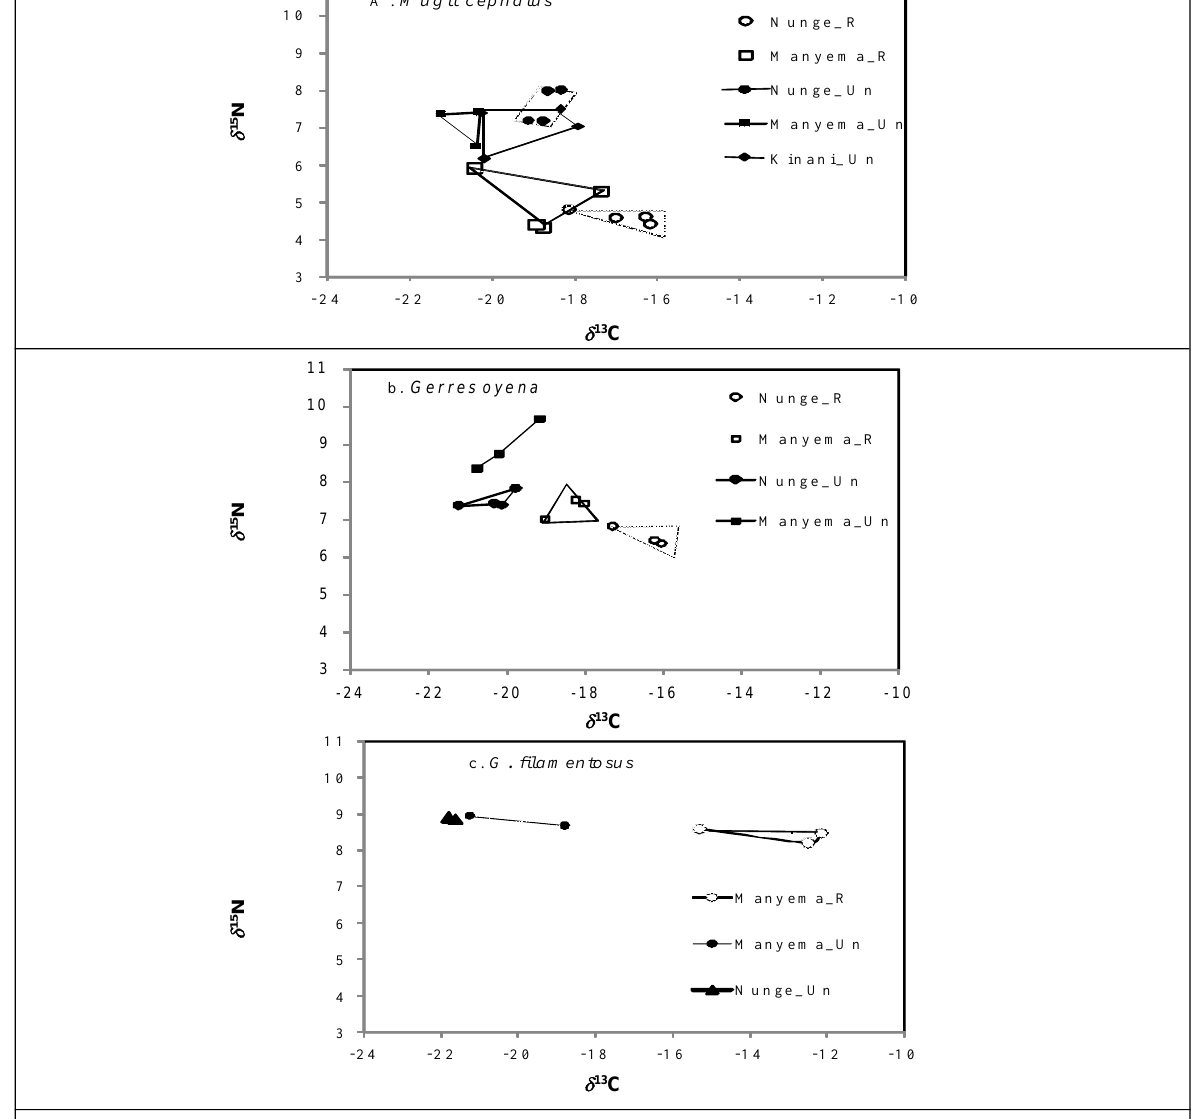
Figure 5: Patterns of stable isotope of 13C and 15N values in muscle tissues of fish from undisturbed (Un) sites (filled symbols) and disturbed sites (R = reservoir) (open symbols) in different mangrove